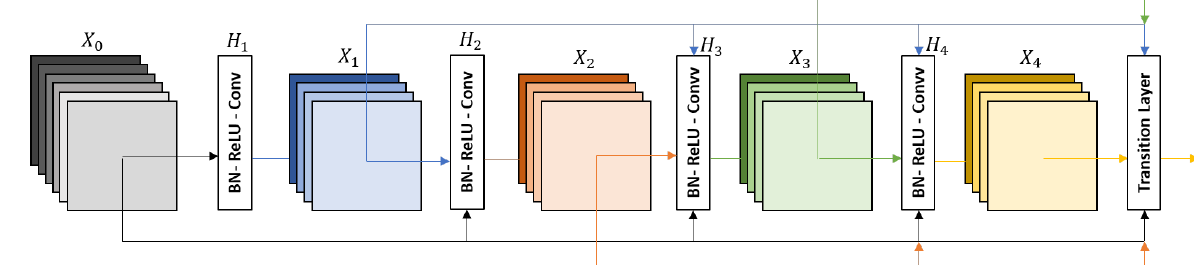
Figure 7. A 5-layer dense block with a growth rate of k = 4. Each layer takes all the preceding feature-maps as an input